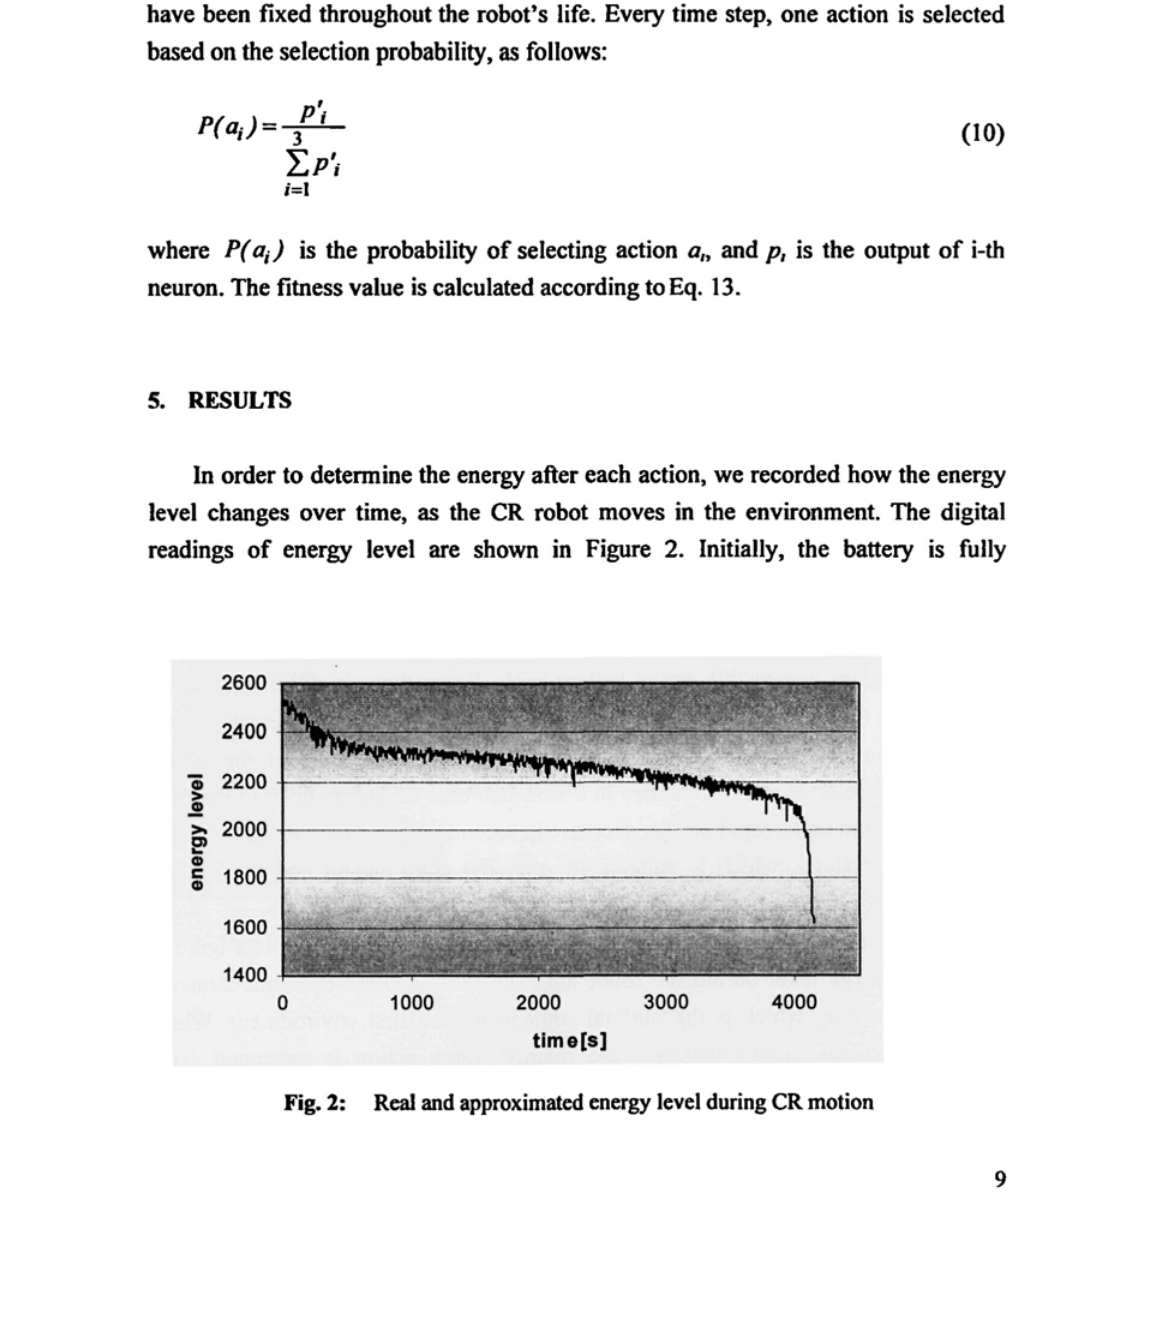
Fig. 2: Real and approximated energy level during CR